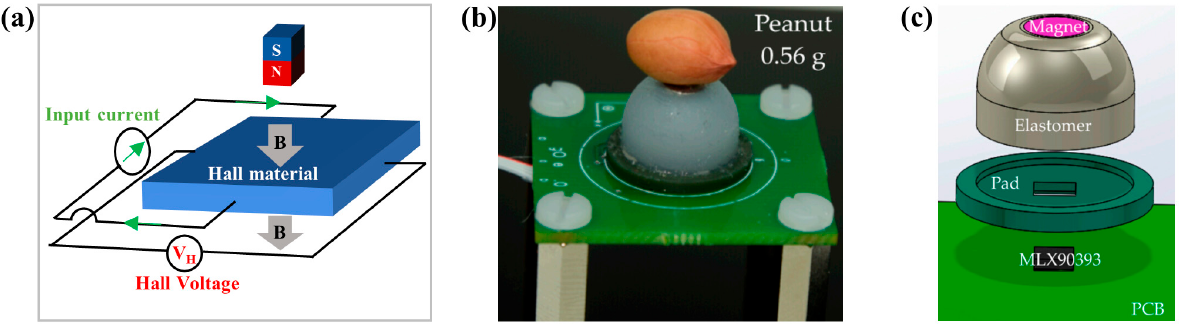
Figure 1. ( a ) Illustration of the Hall effect; ( b ) one of the typical tactile sensors with MLX90393 (designed by Hongbo Wang). Reprinted with permission from Ref. [42]. Copyright 2016, MDPI; ( c ) structure diagram of the tactile sensor with MLX90393. Reprinted with permission from Ref. [42]. Copyright 2016, MDPI.